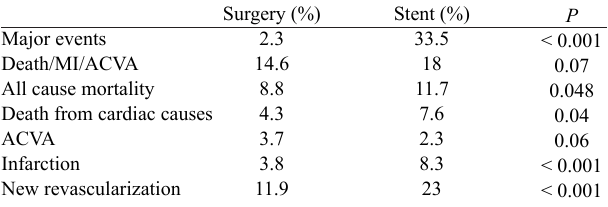
Table 3. 4-years clinical results of the SYNTAX trial Major events Death/MI/ACVA